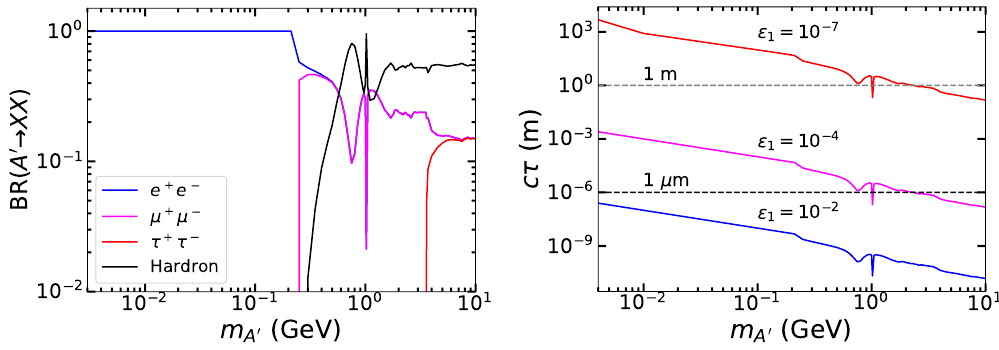
Figure 10 . Left panel: branching ratio of the dark photon. Right panel: proper lifetime of the dark photon with various values of (cid:15) 1 . The dashed black line on the right panel (cid:12)gure indicates the criterion for the LHC prompt decay: c(cid:28) (cid:20) 1 (cid:22)m . where R ( m 2 ) (cid:17) (cid:27) ( e + e (cid:0) ! hadrons) =(cid:27) ( e + e (cid:0) ! (cid:22) + (cid:22) (cid:0) ) takes into account the e(cid:11)ects of A 0 the dark photon mixing with the QCD vector mesons and is taken from ref. [30].